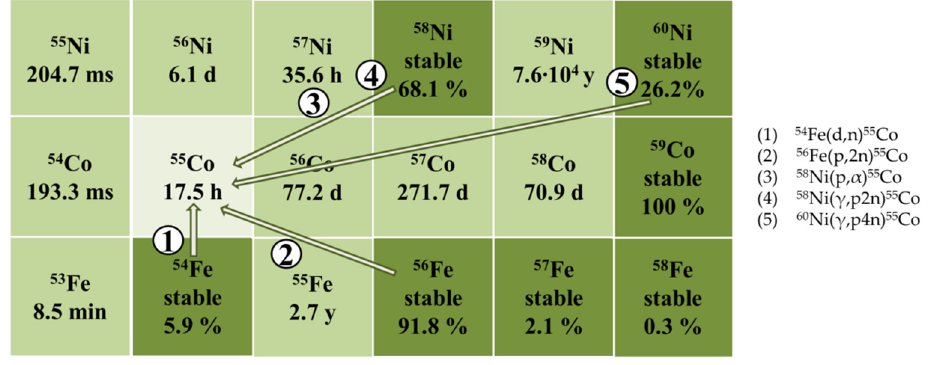
Figure 1. Studied methods of 55 Co production.